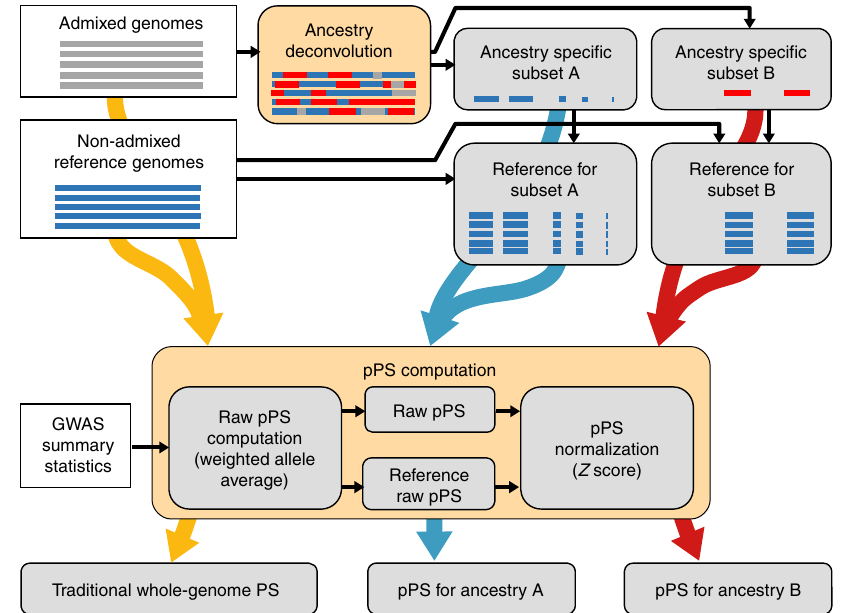
Fig. 1 Schematic work fl ow. A graphical representation of the work fl ow we adopted to obtain normalized PS and ancestry speci fi c pPS. White boxes represent input data, the two key steps of ancestry deconvolution and partial PS computation have an orange